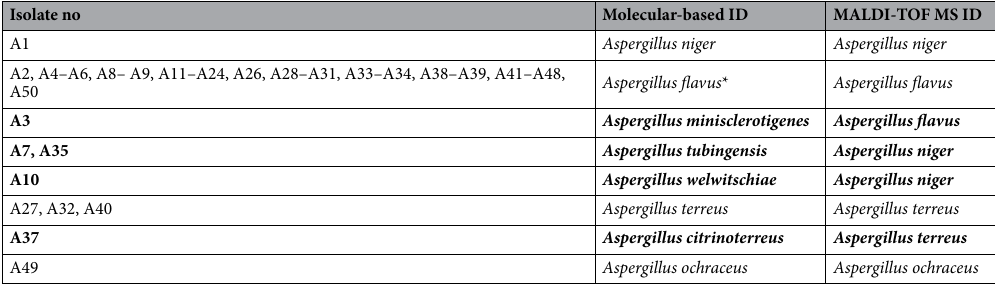
Table 1. Species identification by BenA and CaM gene sequencing and MALDI-TOF MS of 48 Aspergillus isolates. *Molecular identification resulted in Aspergillus flavus or Aspergillus oryzae . Based on the origin of the isolates, all are identified as Aspergillus flavus . The incongruent identifications are given in bold